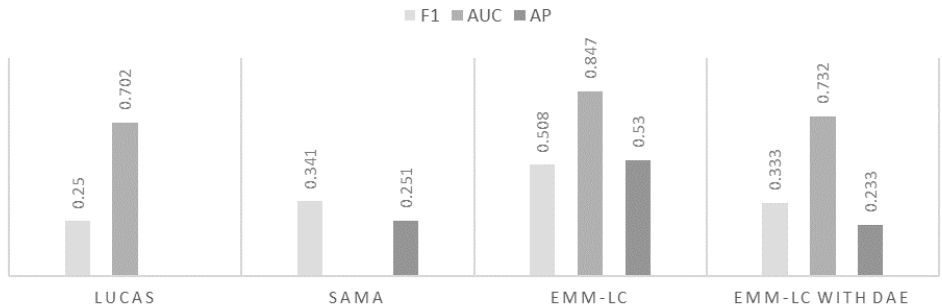
Figure 10. Comparison of EMM-LC Fusion against previous benchmark models.